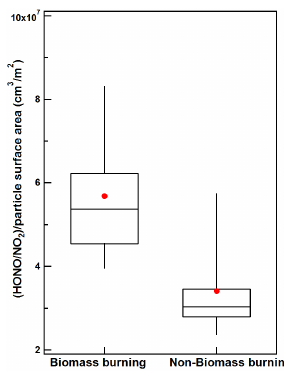
Figure 9. Whisker plot of the ratios between HONO / NO 2 and particle surface area concentration for the samples at steady state (02:00–05:59) with the particle surface area in the range of 1.5– 2.2 × 10 − 9 m 2 cm − 3 during the BB (14 samples) and non-BB peri- ods (21